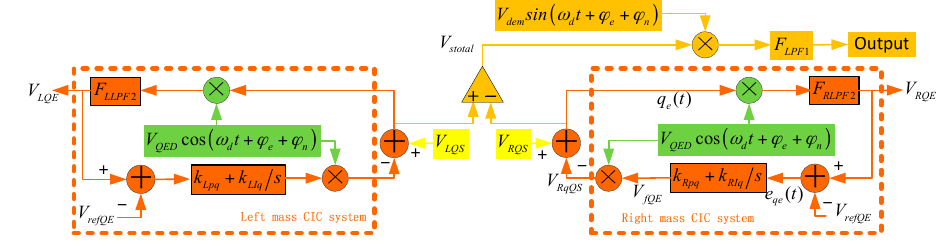
Figure 7. Dual-mass structure CIC system.